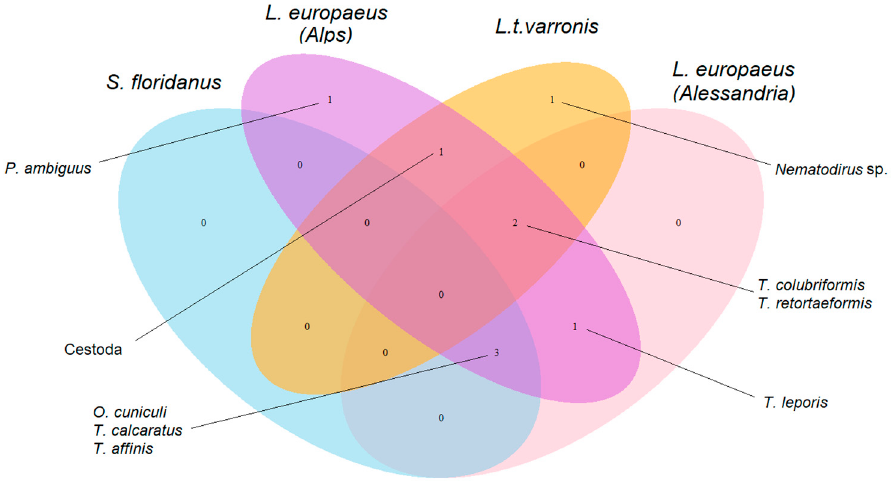
Figure 2. Description of the parasite community reported in the different lagomorph hosts (i.e., Lepus europaeus , Lepus timidus varronis and Sylvilagus floridanus ) from the provinces of Alessandria and Cuneo (herein named Alps) in northwestern Italy.